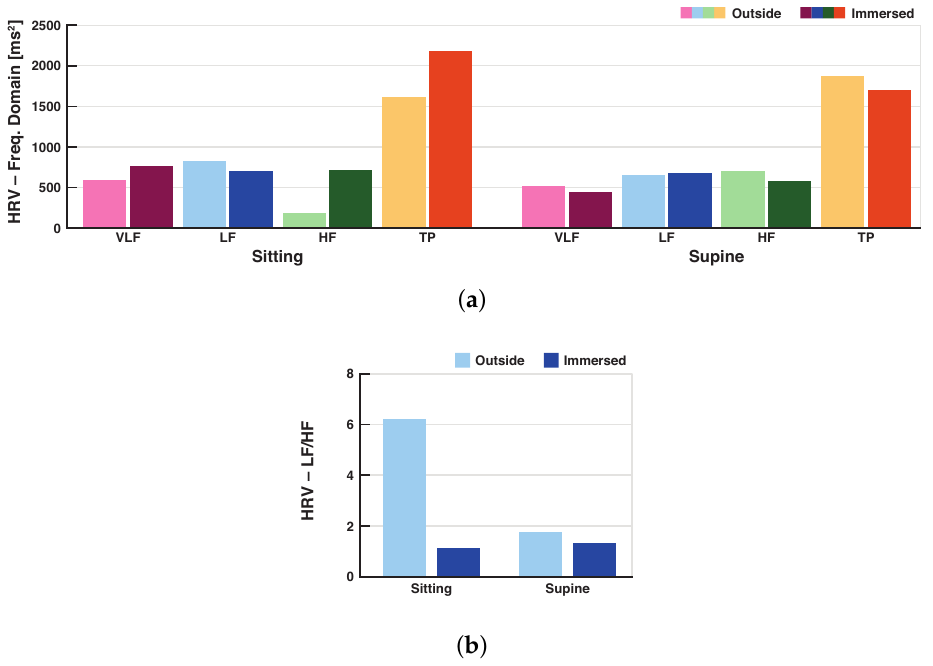
Figure 9. Frequency domain HRV parameters as a mean over all subjects. In ( a ), the changes in the very low frequency power (VLF), the low frequency (LF), and high frequency (HF) power as well as the total power (TP) are visualized between the outside-the-water (bright colors) and immersed condition (dark colors). On the left side of each subfigure the changes in the sitting position and on the right the changes in the supine position are given. In ( b ), the differences in the ratio LF/HF are